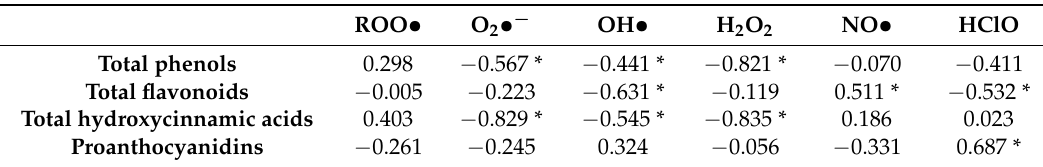
Table 4. Spearman coefficient for correlation between the scavenging capacity of the reactive species and the phenolic compound content. ROO • O 2 • − OH • H 2 O 2 NO • HClO Total phenols